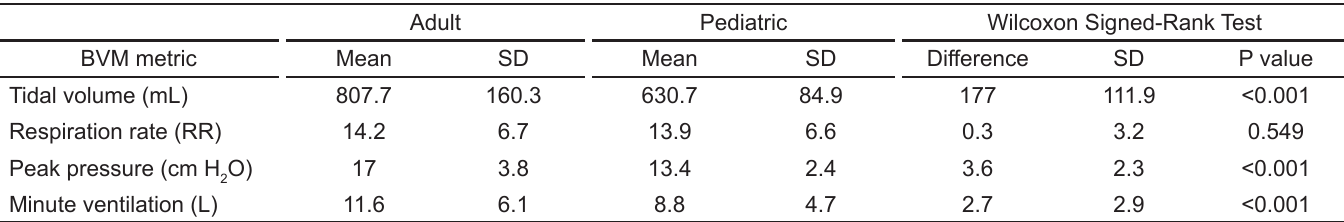
Table 1. Mean and standard deviation (SD) for adult and pediatric bag valve mask metrics and results from Wilcoxon Signed-Rank analysis.